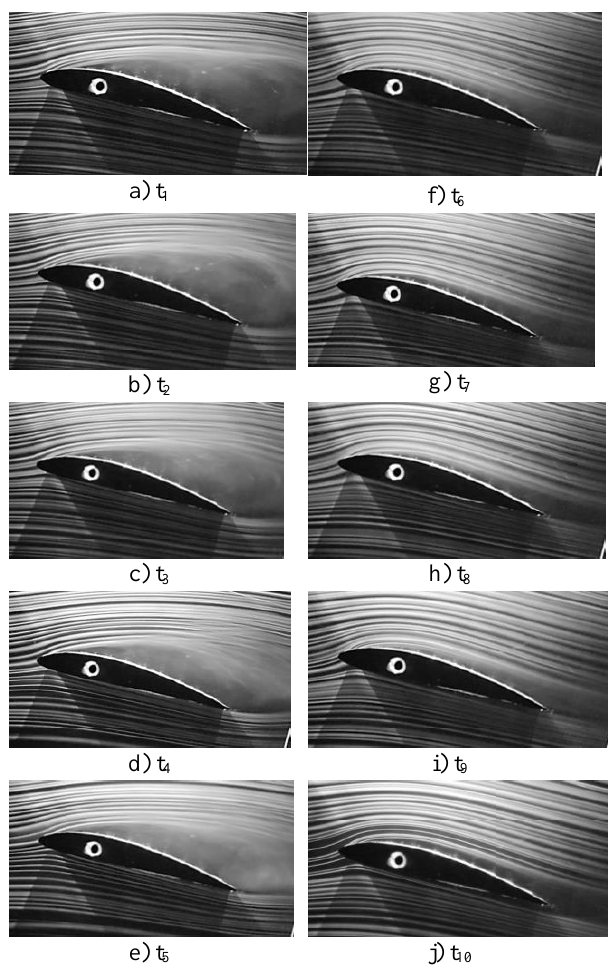
Fig. 3. Results of time-dependent smoke-wire experiment Re=5x10 4 , α=14º